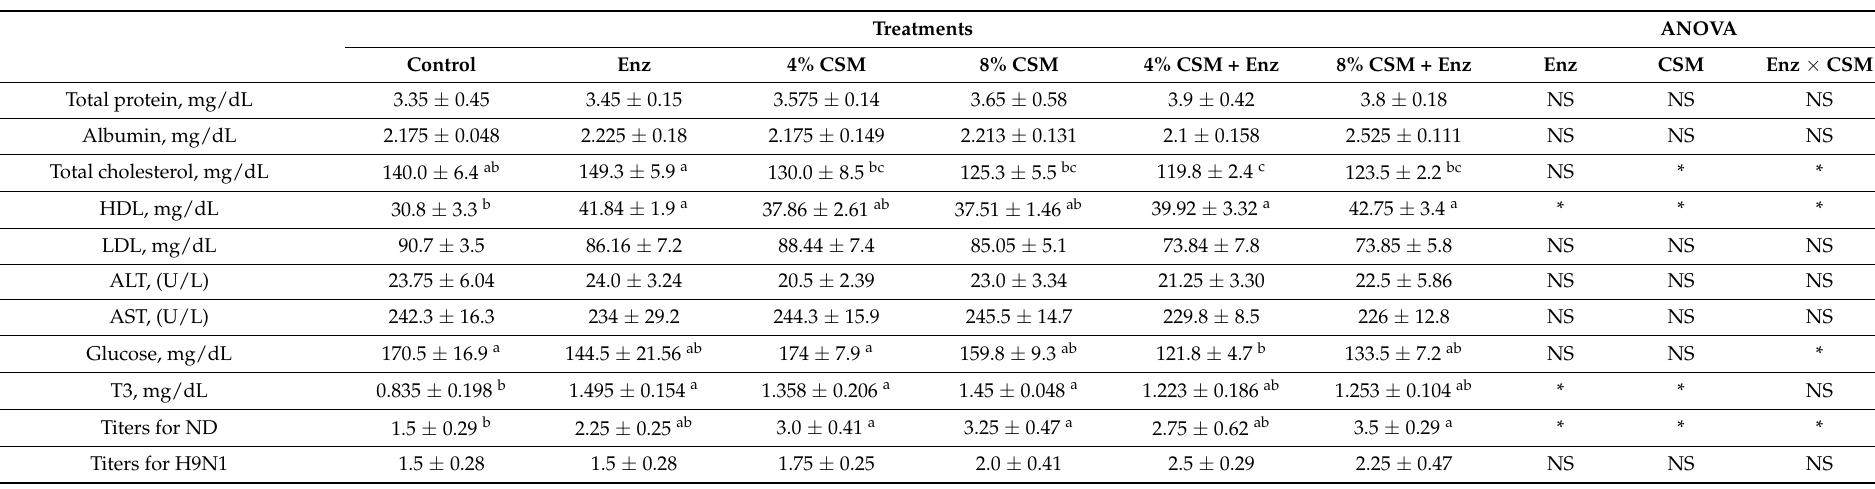
Table 6. Effects of feeding corn silk meal and/or NSP enzyme on serum biochemical